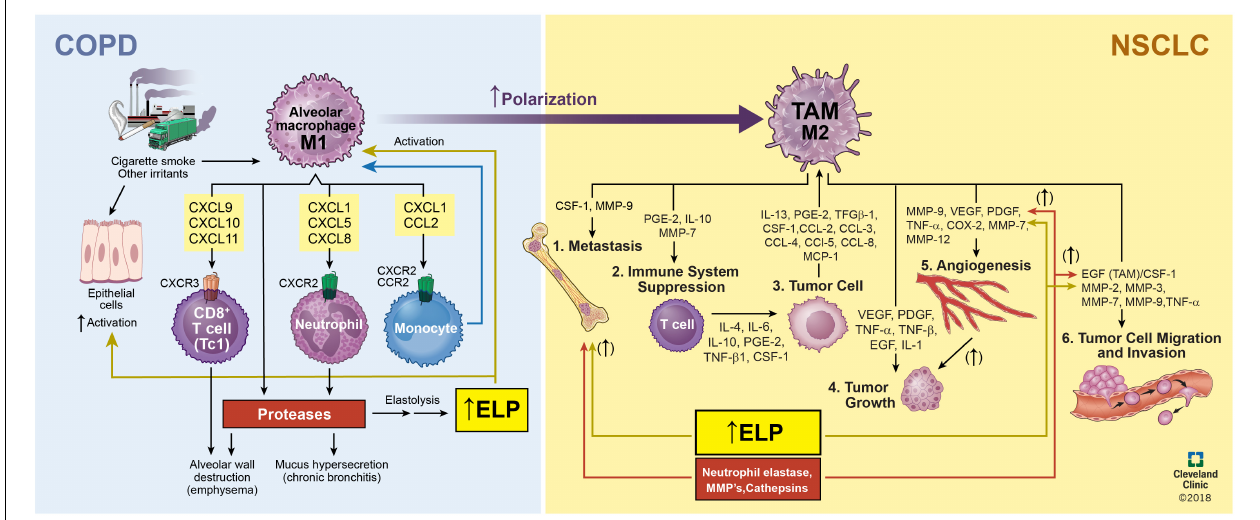
FIGURE 2 | Relationship and interplay between COPD and NSCLC. Inhalation of inflammatory-generating particulates causes the degradation of the alveolar elastic matrix thereby decreasing O 2 , increasing sputum production, and prolonging exacerbations to bring about the onset of COPD. Continued worsening of COPD due to secretion of proteases, inflammatory neutrophils, angiogenesis formation due to vascular endothelial cells, and macrophage polarization from an M1, pro-inflammatory, to M2, pro-tumorigenic, phenotype brings about the onset of NSCLC.